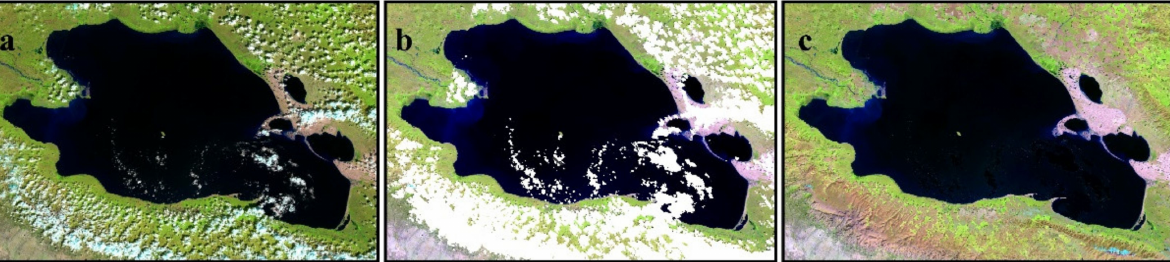
Figure 3. Illustration of bimonthly image construction, ( a ) original image with least clouds and shadows in September 2016; ( b ) clear image after cloud and shadow masking; ( c ) composite bimonthly image after void filling. RGB channels were synthesized using ‘swir1’, ‘nir’, and ‘red’